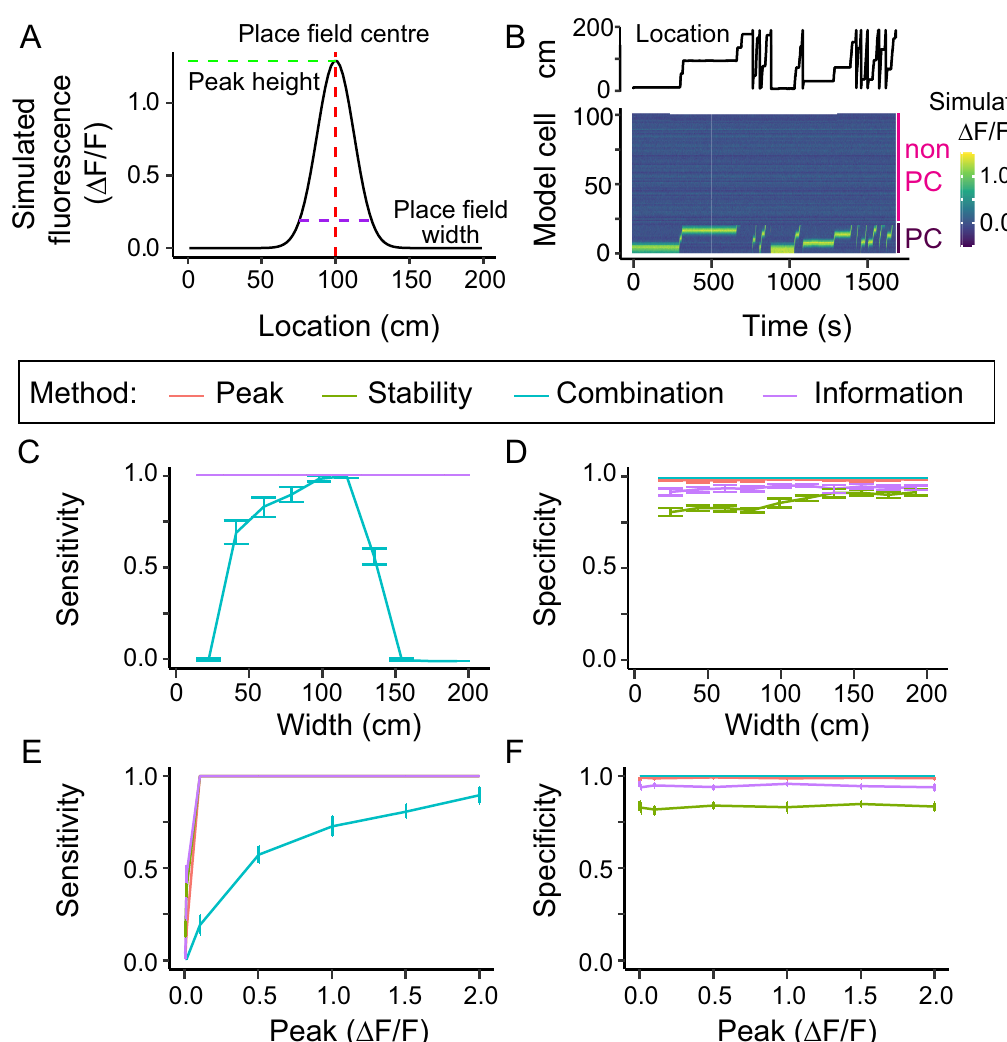
Fig 2. Place cell model and its effect on place cell detection. (A) Gaussian model of the fluorescence of a place field depending on the location (x-axis). The model takes the following parameters: the centre of the place field (red dashed line), the place field width (purple dashed line) and the peak of the Gaussian (green dashed line). (B) example fluorescence profile over time of a model data set containing 20 place cells (cells 1–20) and 80 non-place cells (cells 21–100), generated using the location trace shown. (C, E) Specificity and (D, F) sensitivity of the different methods as a function of the place field width (C, D) or peak (E, F). Note in D all methods except the Combination method had a sensitivity of 1 across all widths, and the lines overlap. In E there is similar overlap for peak values above 0.1. Data are means of 10 simulations. Error bars represent 95% confidence